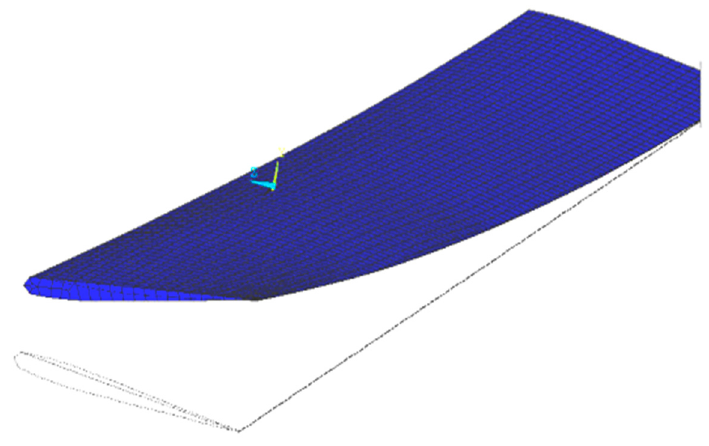
Figure 7. The deformedfinite element model.